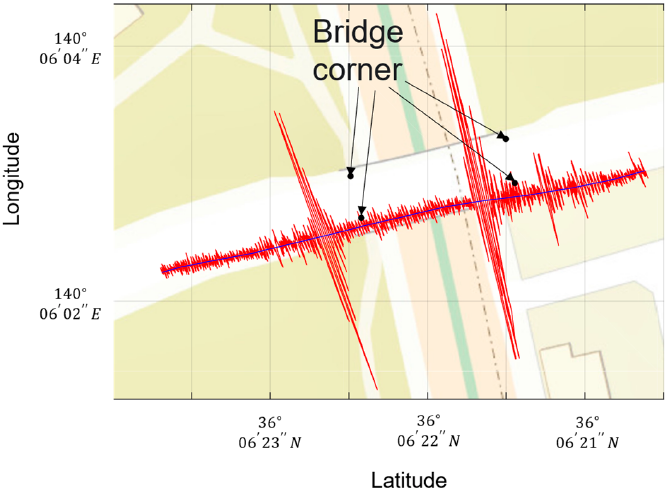
Figure 6. Data measured on the left side of the front wheels for unsprung weight when running Bridge A.